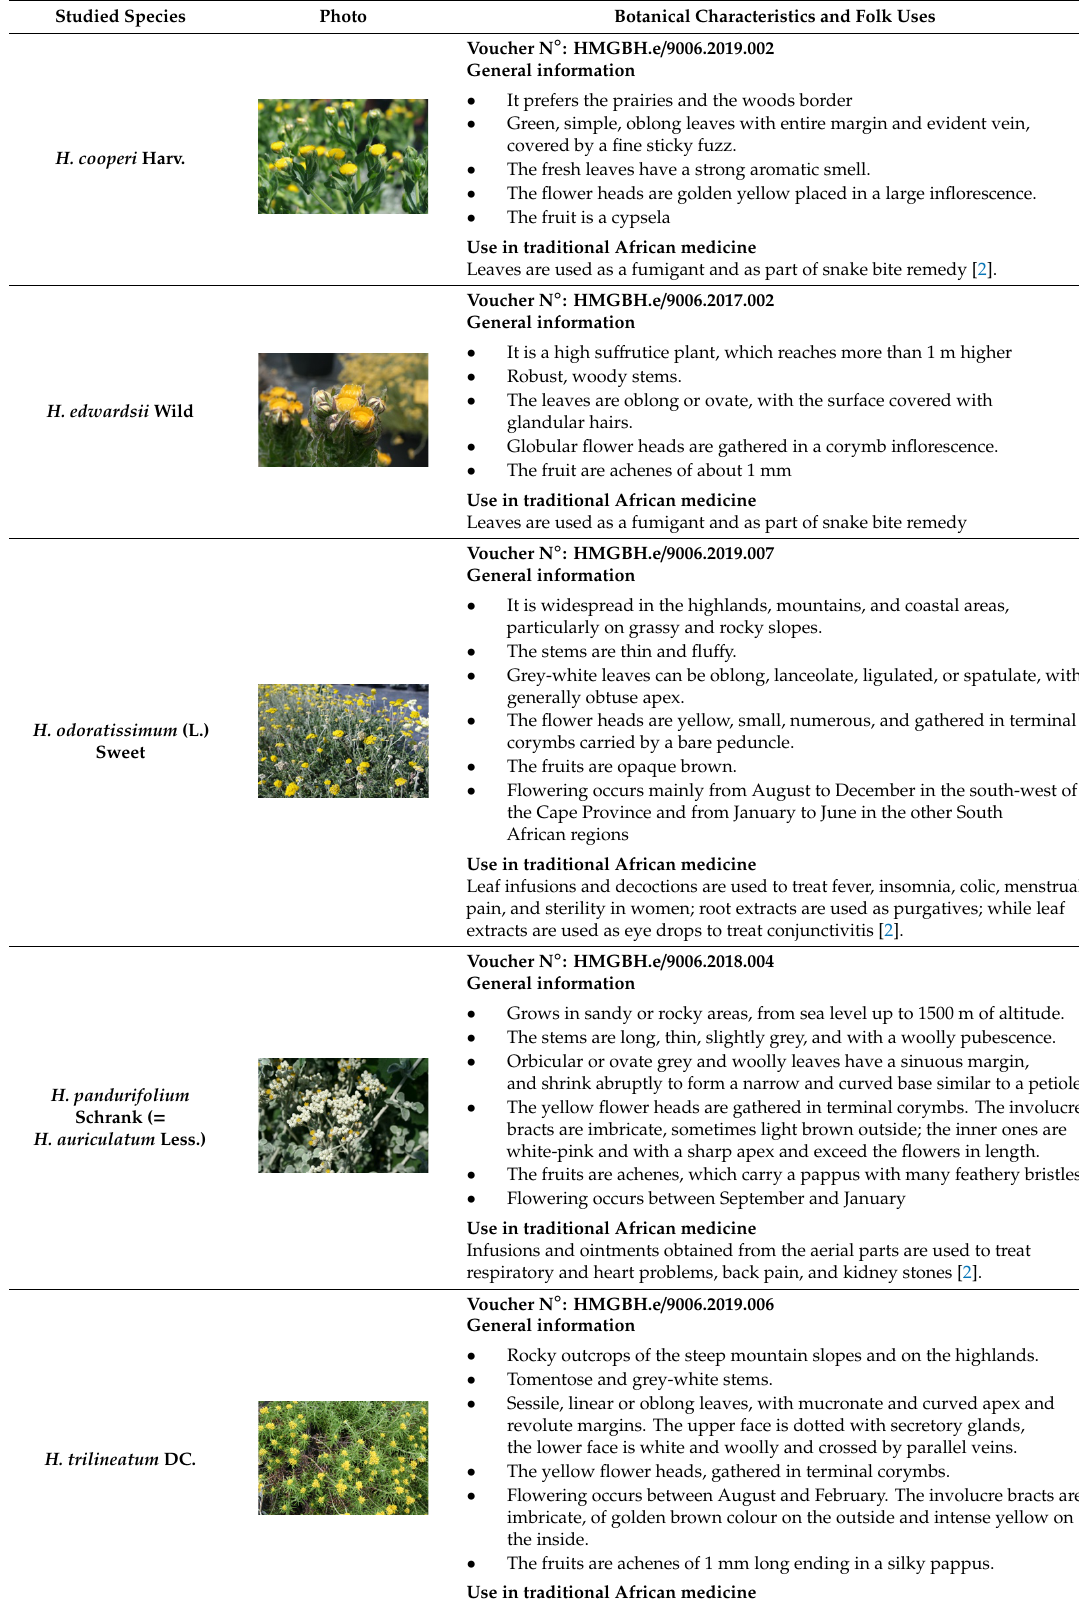
Table 7. Botanical characteristics and traditional medicinal use of the investigated species of Helichrysum .